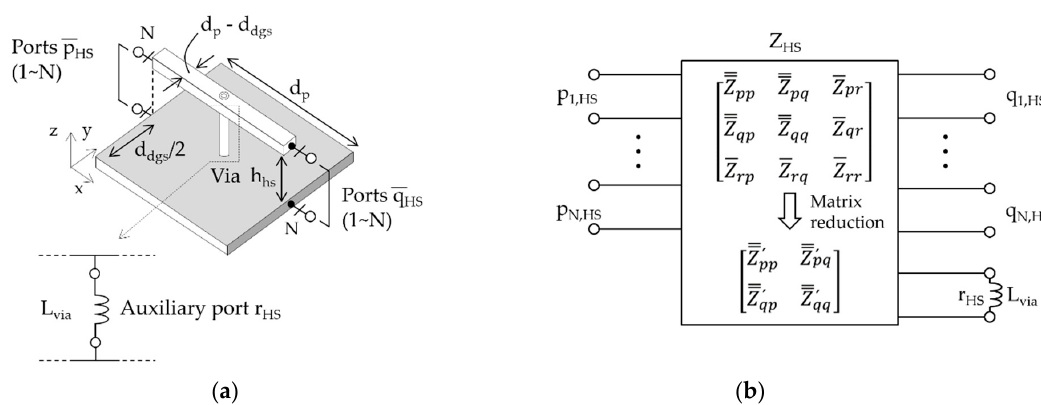
Figure 7. ( a ) Ports and design parameters; ( b ) the Z-matrix (Z HS ) of the high-Z o segment.